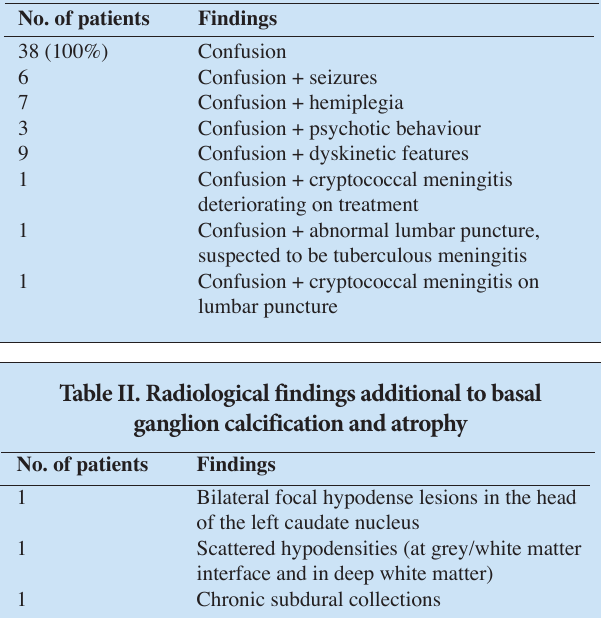
Table I. Clinical presentations